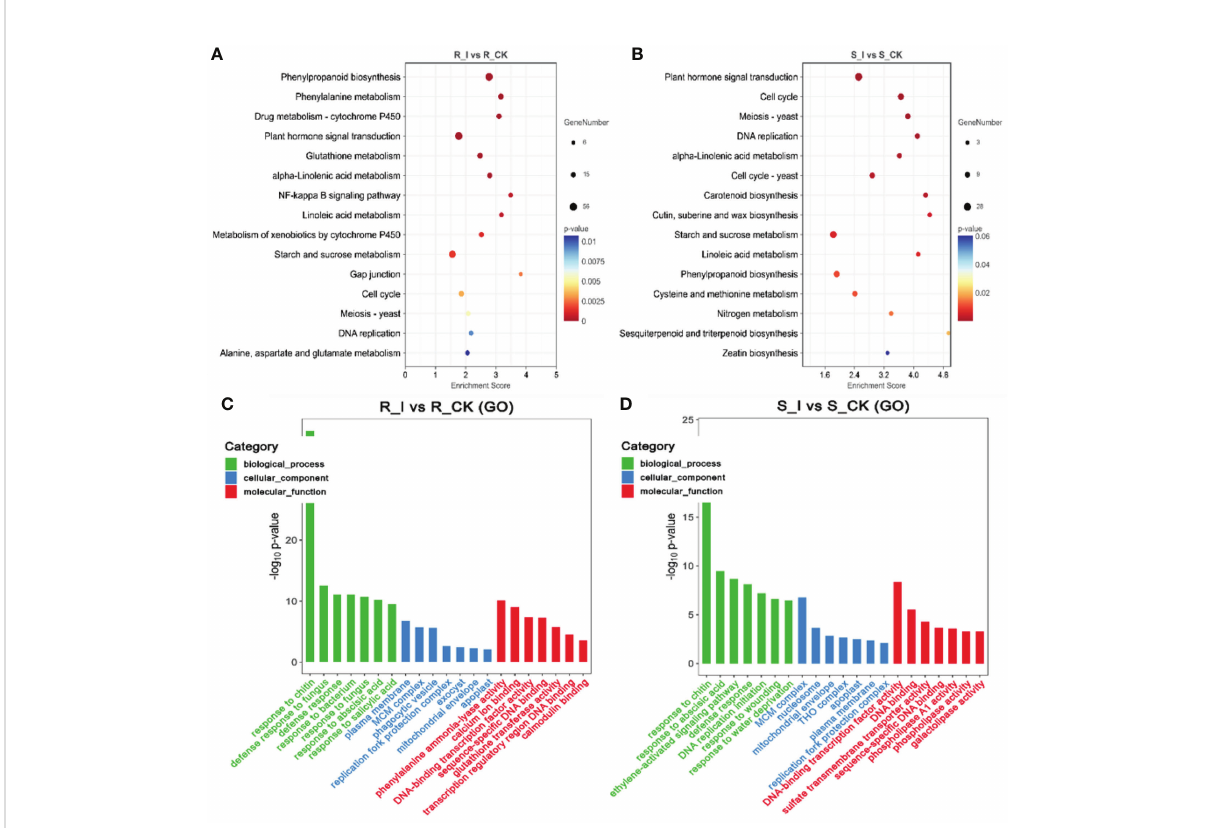
FIGURE 5 Pathway functional analysis of DEGs. The X and Y-axis represent enrichment factor and pathway names, respectively. A colored bubble represents p-value, and Rich Factor refers to the value of enrichment factor, which is the quotient of foreground value (the number of DEGs). (A) DEGs that were up-regulated in the R_I vs. R_CK groups. (B) DEGs that were up-regulated in the S_I vs. S_CK groups. (C, D) GO analysis of DEGs classi fi ed as biological, cellular, or molecular